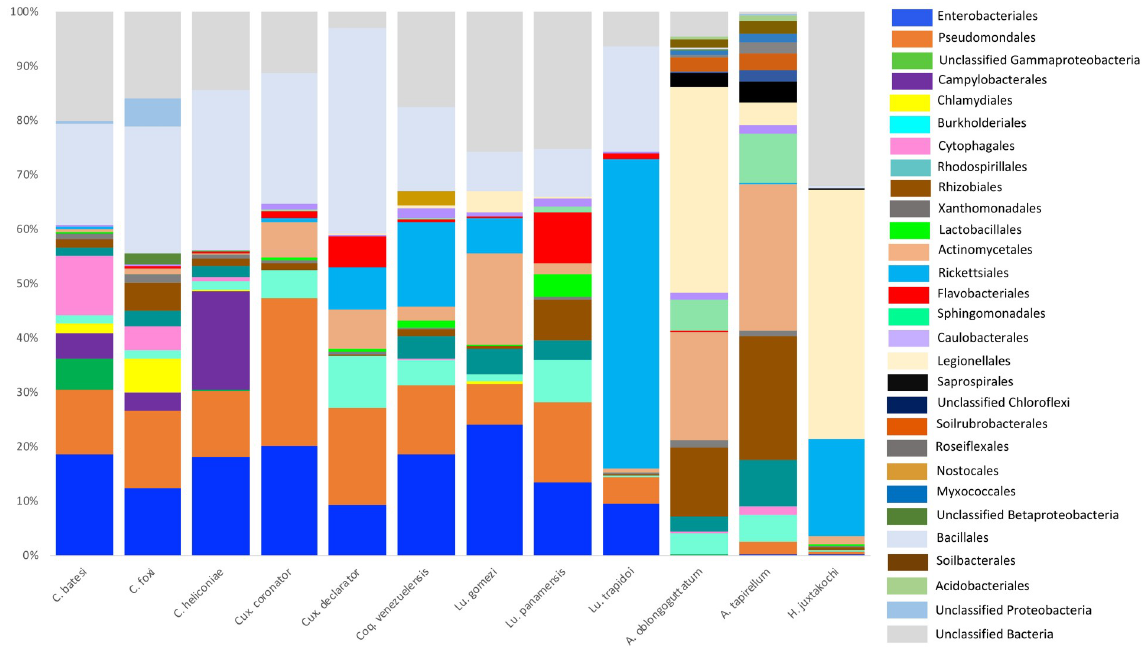
Fig 1. Relative abundances of bacterial orders above 0.1% summarized for each blood-feeding arthropod species.